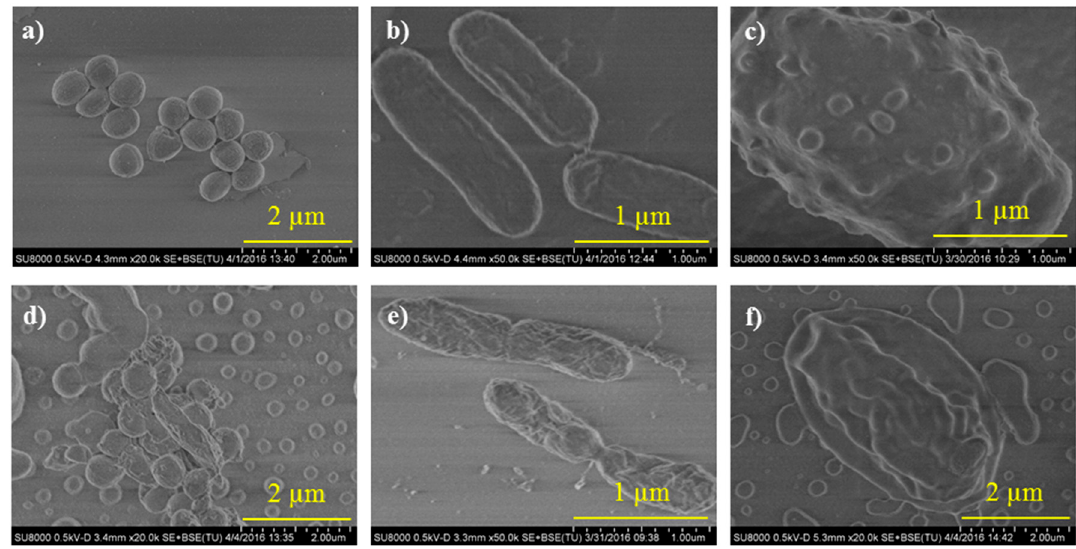
Figure 4. FE-SEM images of: ( a , d ) S. aureus ; ( b , e ) P. aeruginosa ; and ( c , f ) C. parapsilosis after incubation for 24 h (48 h for C. parapsilosis ) on control films of PAN ( a – c ) and on films of the blend PAN/P(AN 0.6 - co -MTA4 0.4 -Bu) ( d – f ).